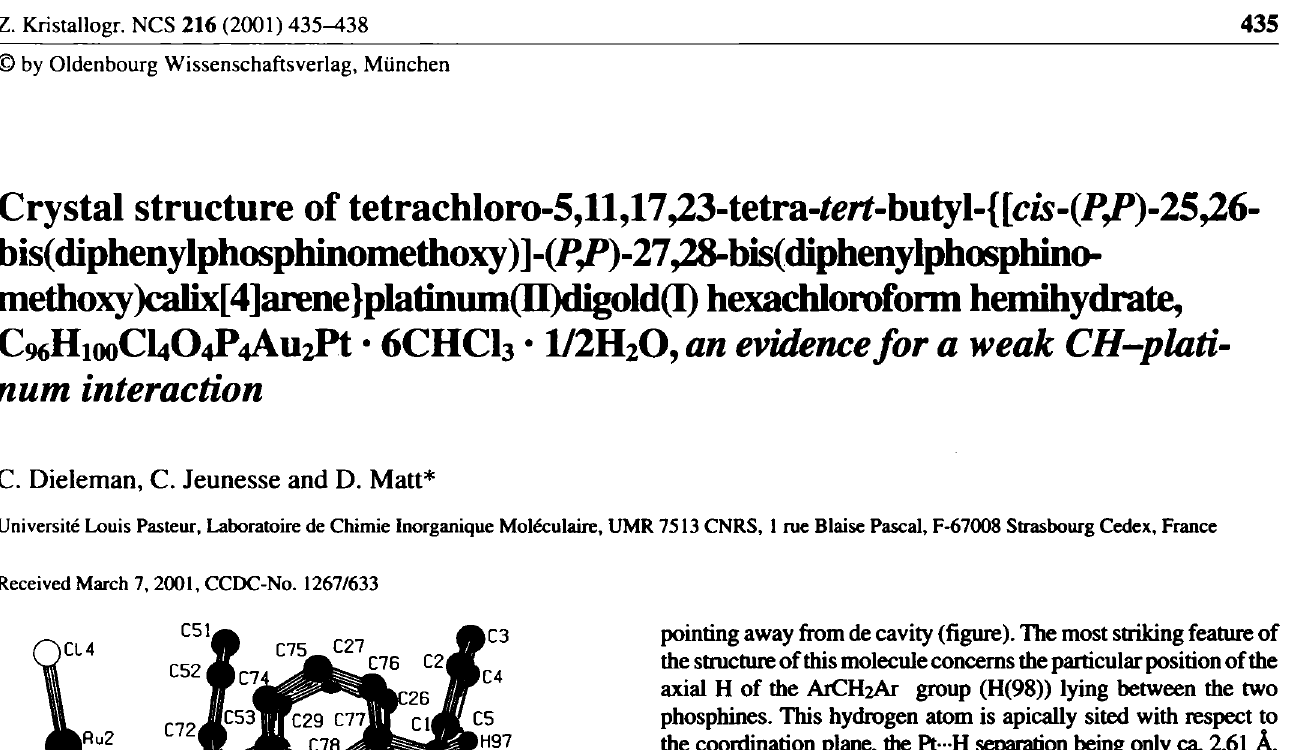
Table 1. Data collection and handling.